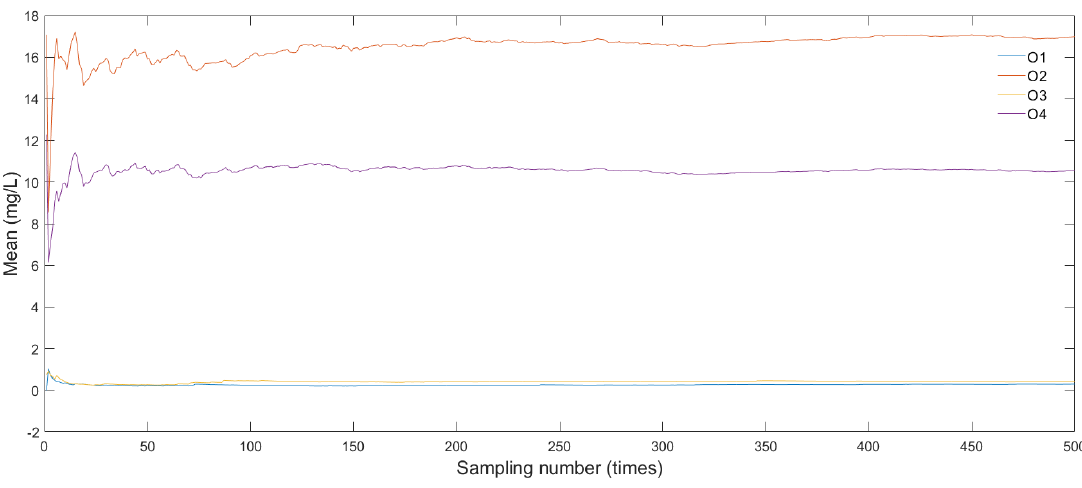
Figure 7. Iterative curves of mean for O1–O4.